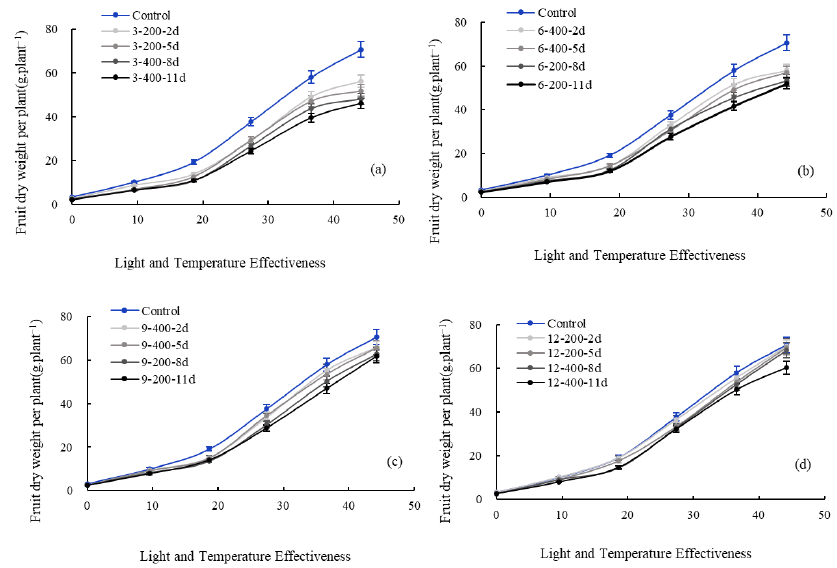
Figure 6. Variation trend of fruit dry weight per plant of cucumber under LT and PL stresses. ( a )